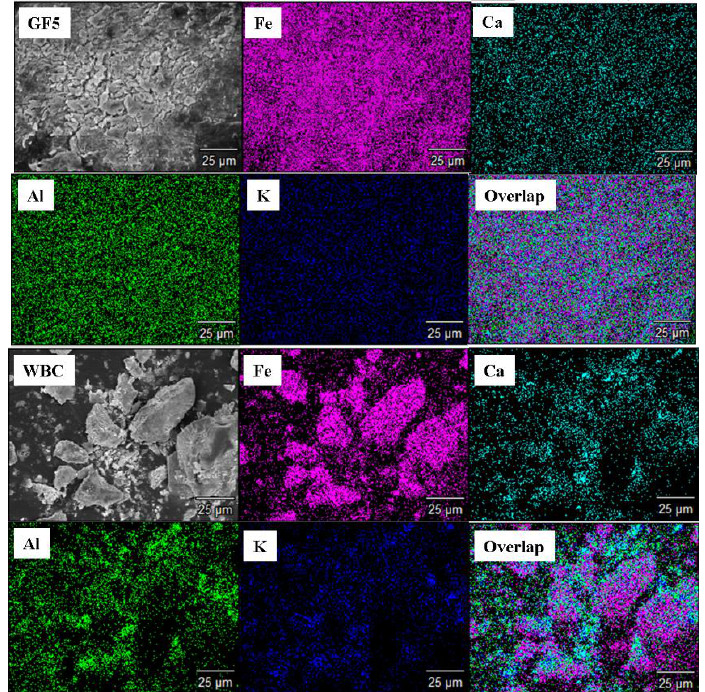
Figure 4. SEM images and EDS elemental mapping of SCS and WBC catalyst.